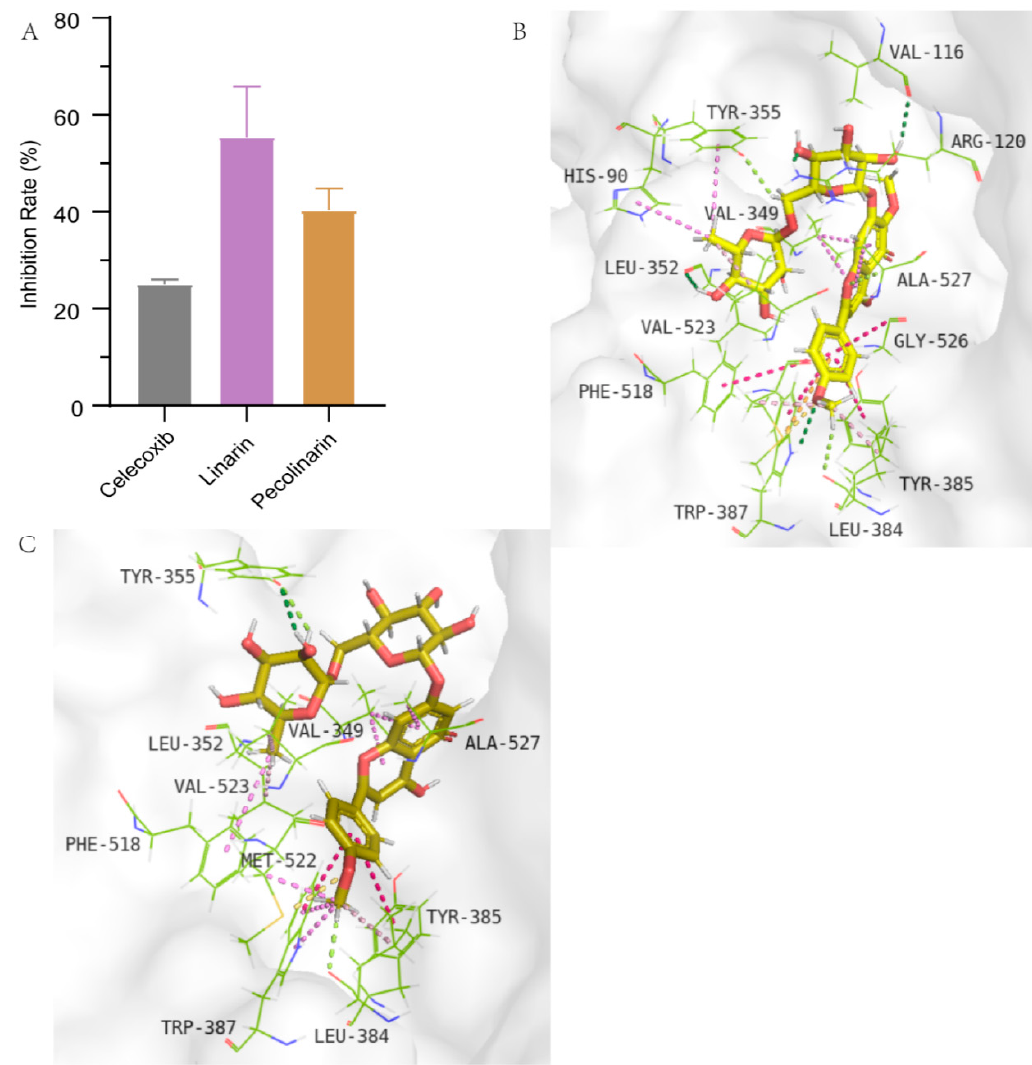
Figure 6. Results of inhibition assay and molecular docking analysis of linarin and pectolinarin with COX-2. ( A ) The inhibition rates of linarin (50 µg/mL), pectolinarin (50 µg/mL) and celecoxib (50 nM) on the activity of COX-2. ( B ) Pectolinarin binds in the cyclooxygenase active site of COX-2 (PDB code 6V3R). ( C ) Linarin binds in the cyclooxygenase active site of COX-2 (PDB code 6V3R).